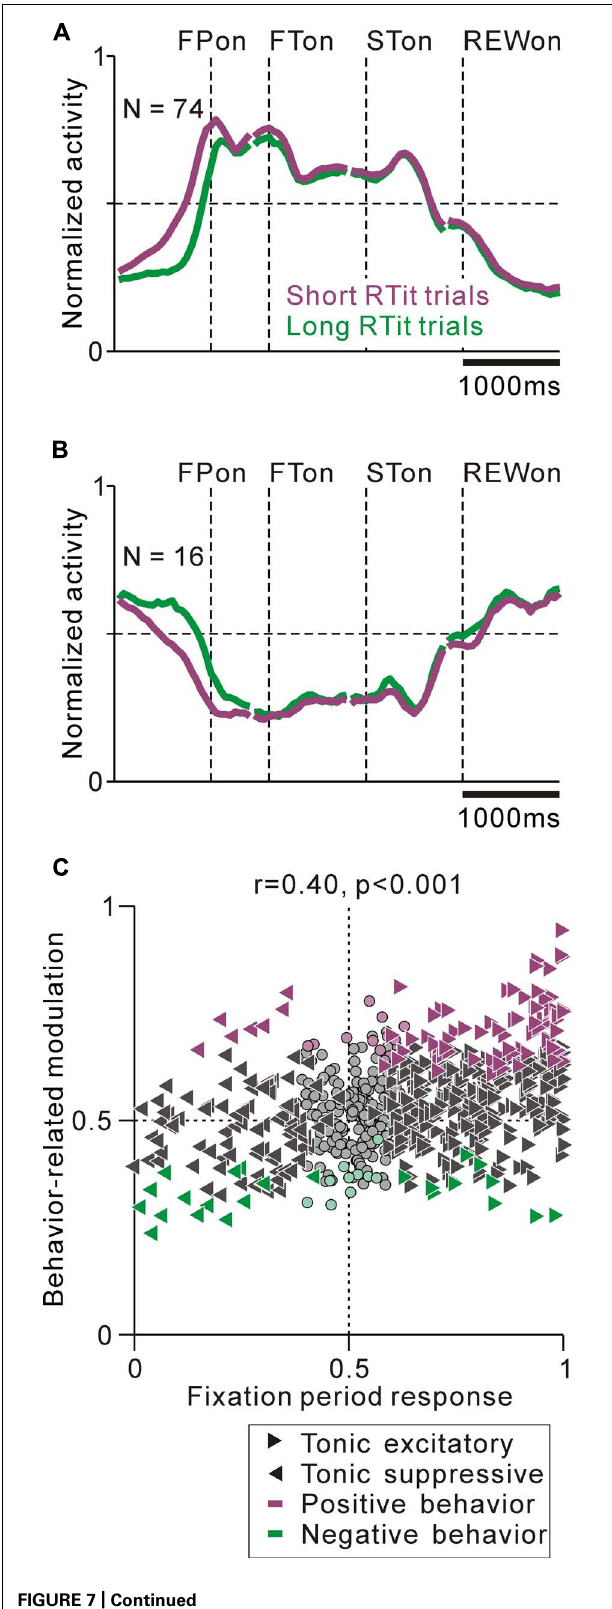
0–600 ms after the appearance of the initial stimulus versus the pre-fixation period at 0–600 ms before the appearance of the initial stimulus.